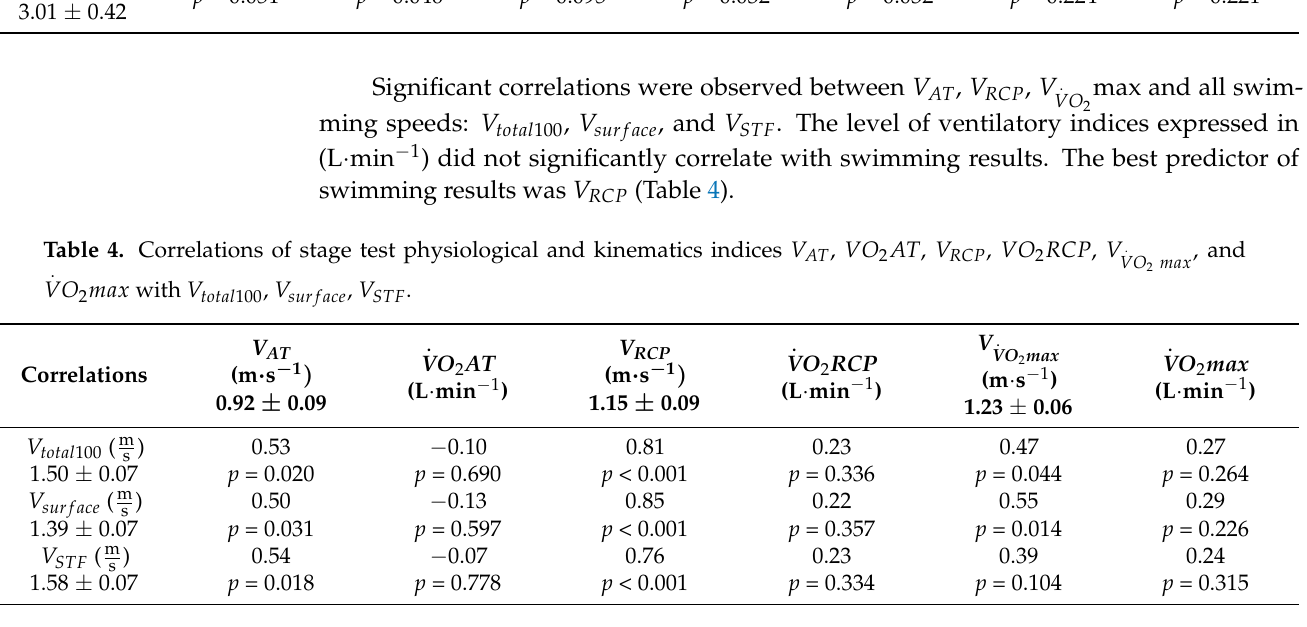
. . . VO 2 AT , VO 2 RCP , and VO 2 max with anthropometric,